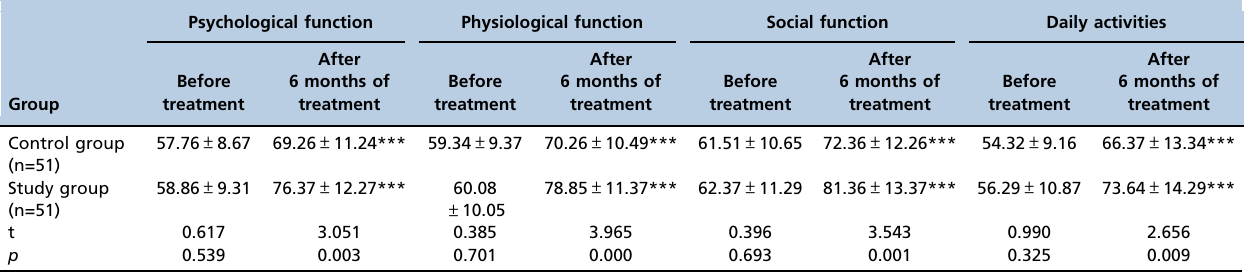
Figure 5 - Comparison of TIMP-1 and MMP-9 levels. A: TIMP-1 levels and B: MMP-9 levels. *** indicates p o 0.001 when compared to levels before treatment; ### indicates p o 0.001 when compared to the control group. TIMP-1: matrix metalloproteinase inhibitor-1; MMP-9: matrix metalloproteinase-9. Table 3 - Comparison of WHOQOL-BREF scale scores (Mean scores ±